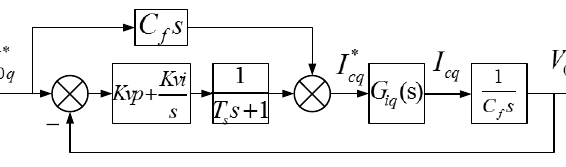
Figure 6. Structure diagram of voltage loop control.